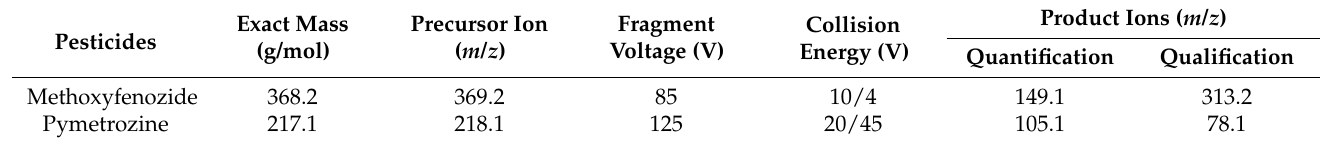
Table 2. Optimization of MS/MS conditions for methoxyfenozide and